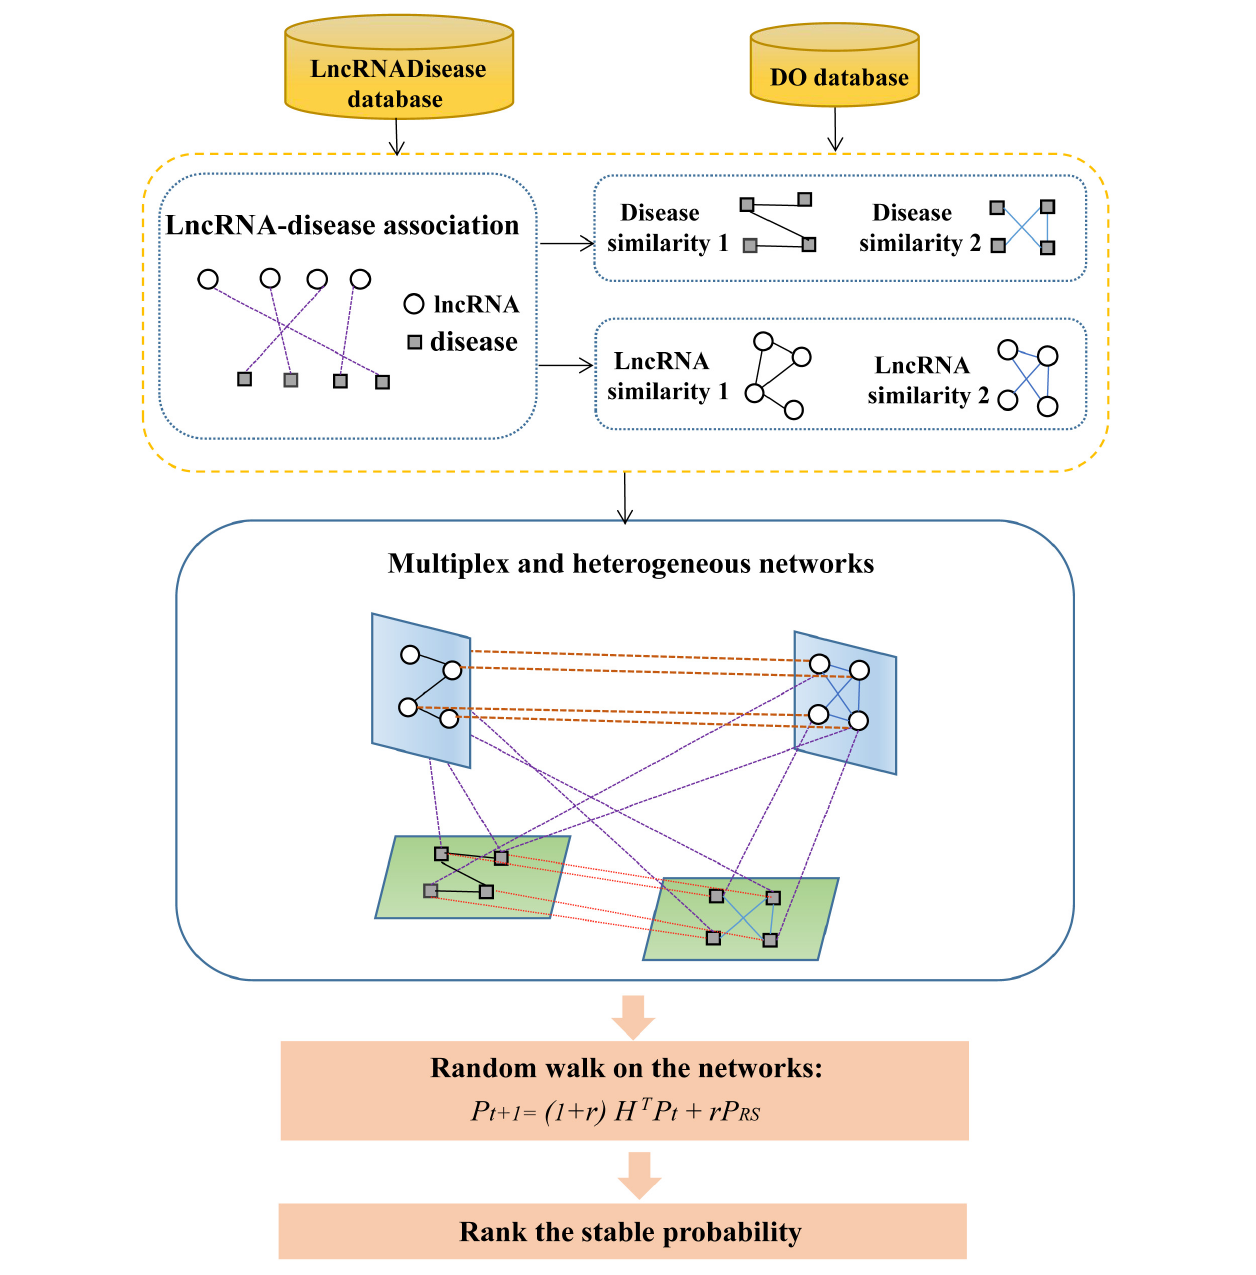
FIGURE 1 | The framework of